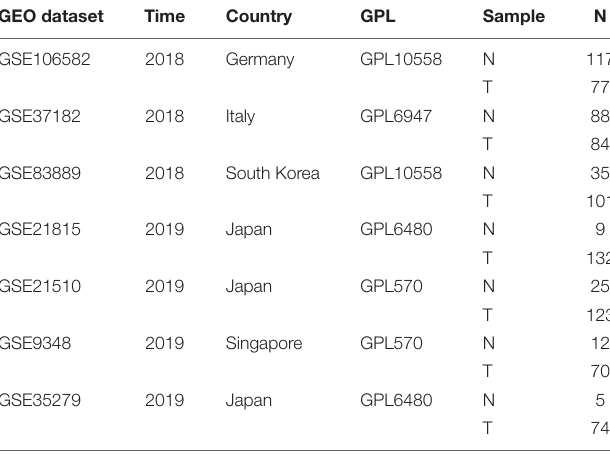
TABLE 2 | Information of GEO dataset involved in this